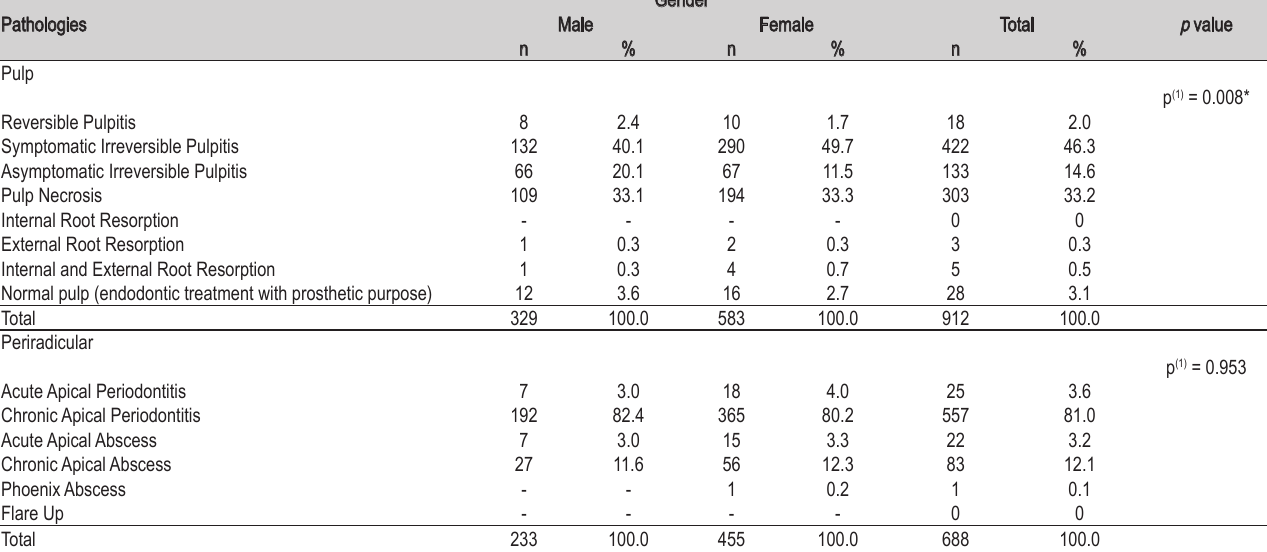
Table 1 - Prevalence of treated teeth due to pulp and periradicular pathologies according to